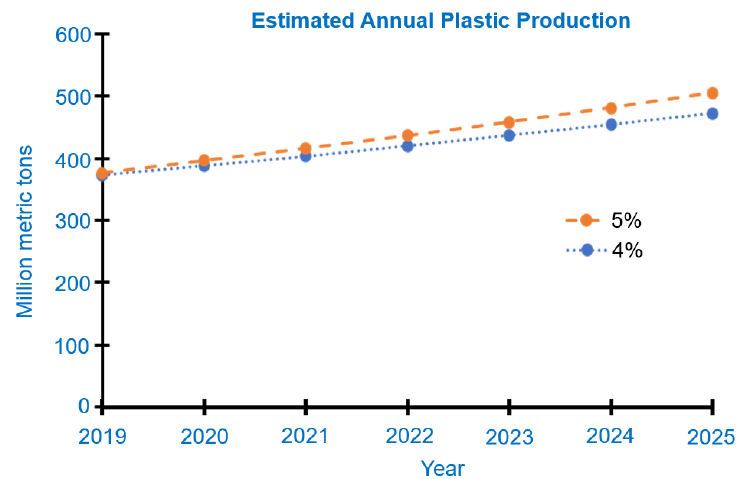
Figure 1. Estimated plastic production between 2019 and 2025. The annual growth is projected both at 4% and 5%.